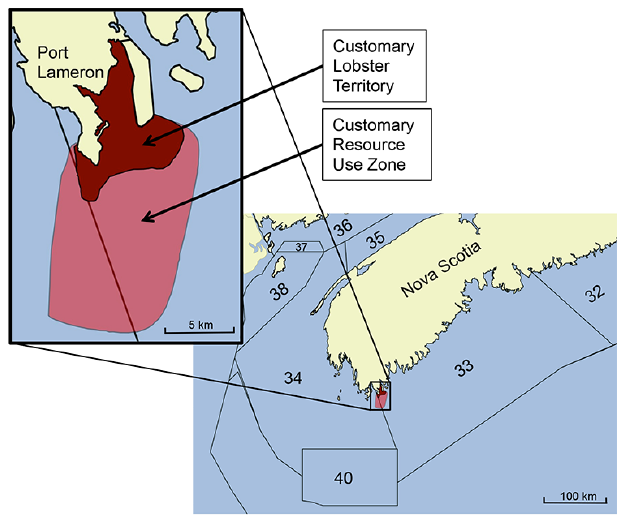
Fig. 2 . Comparison of customary lobster and general resource territory for Port Lameron described in Davis (1984 a ) and current state-defined resource boundaries. Numbers correspond to lobster fishing areas or districts. Data source: Coffen-Smout et al.